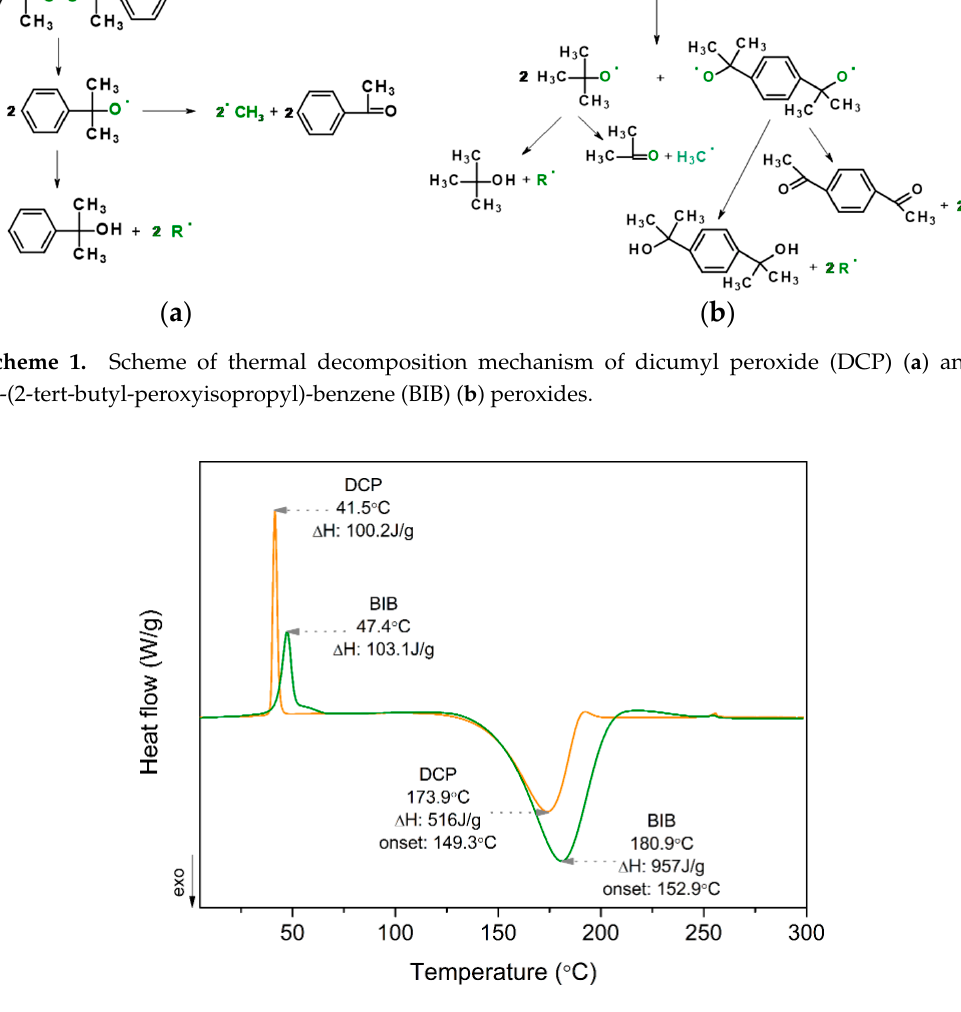
Scheme 1. Scheme of thermal decomposition mechanism of dicumyl peroxide (DCP) ( a ) and di-(2- tert-butyl-peroxyisopropyl)-benzene (BIB) ( b ) peroxides.